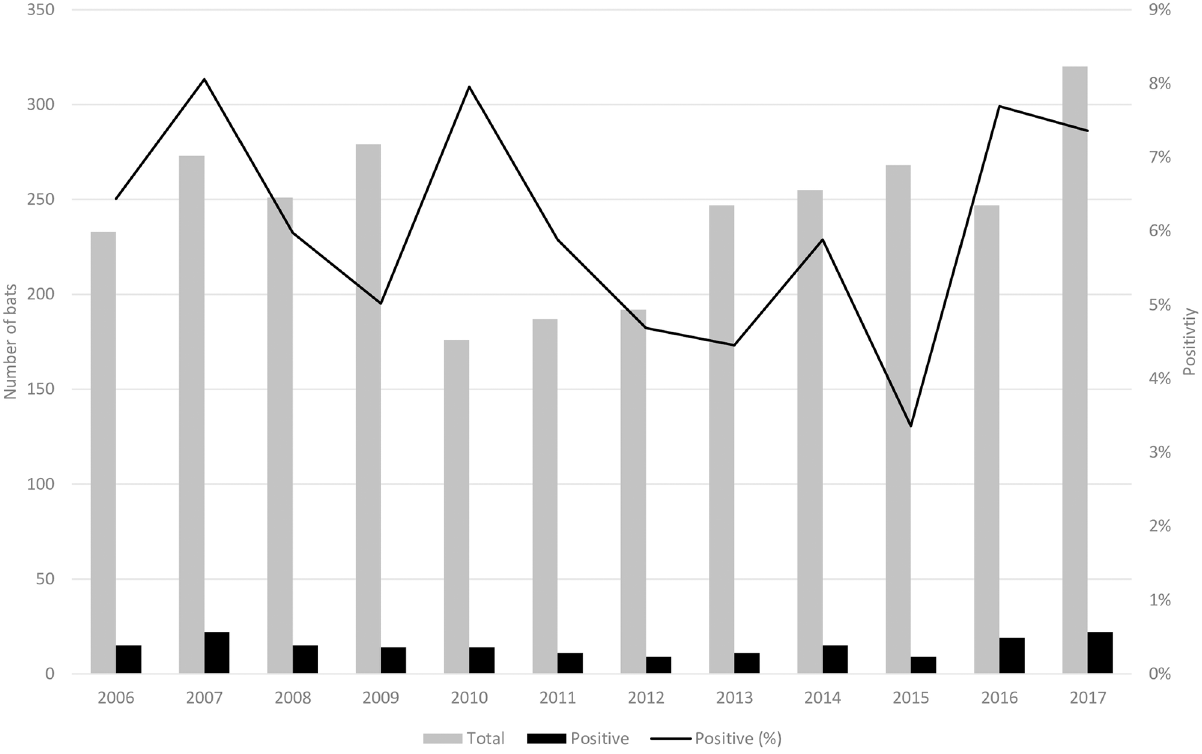
Fig 3. Numbers of identified bats with definitive RABV test results (N = 2,928) and RABV positivity by year, Washington State—2006–2017.